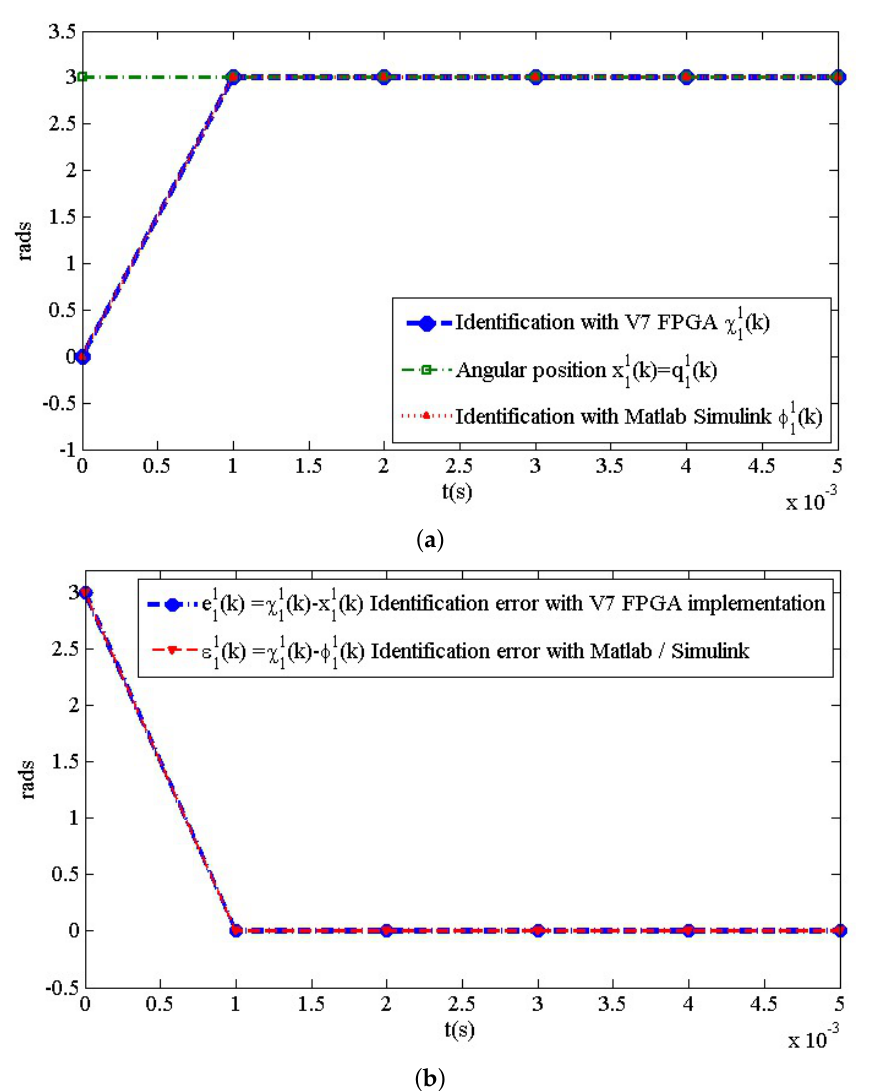
( k ) ( k ) . Figure 5. ( a ) Identification results and ( b ) identification error for the first state of joint 1 x 1 1 1 ( k ) . 1